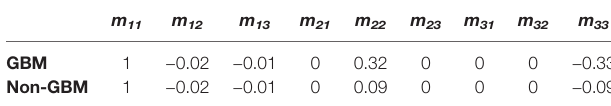
TABLE 1 | Average values of 3×3 Mueller matrix elements of detected GBM samples with non-GBM brain tissues.